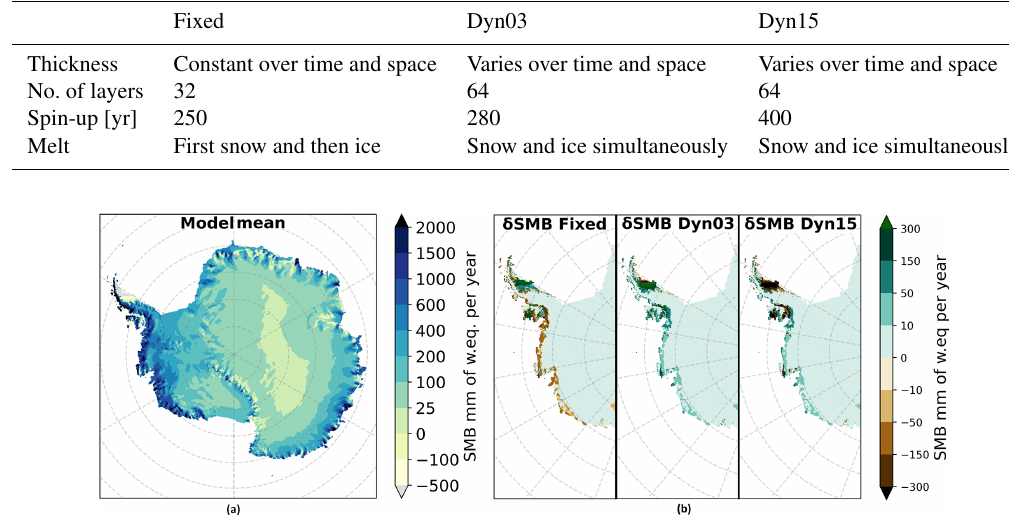
Figure 1. Mean SMB from 1980 to 2017 in mmyr − 1 of w.e. (a) The mean of the model mean; note the nonlinear colour bar. (b) West AIS where the δ SMB has the largest differences between model versions (model minus ensemble